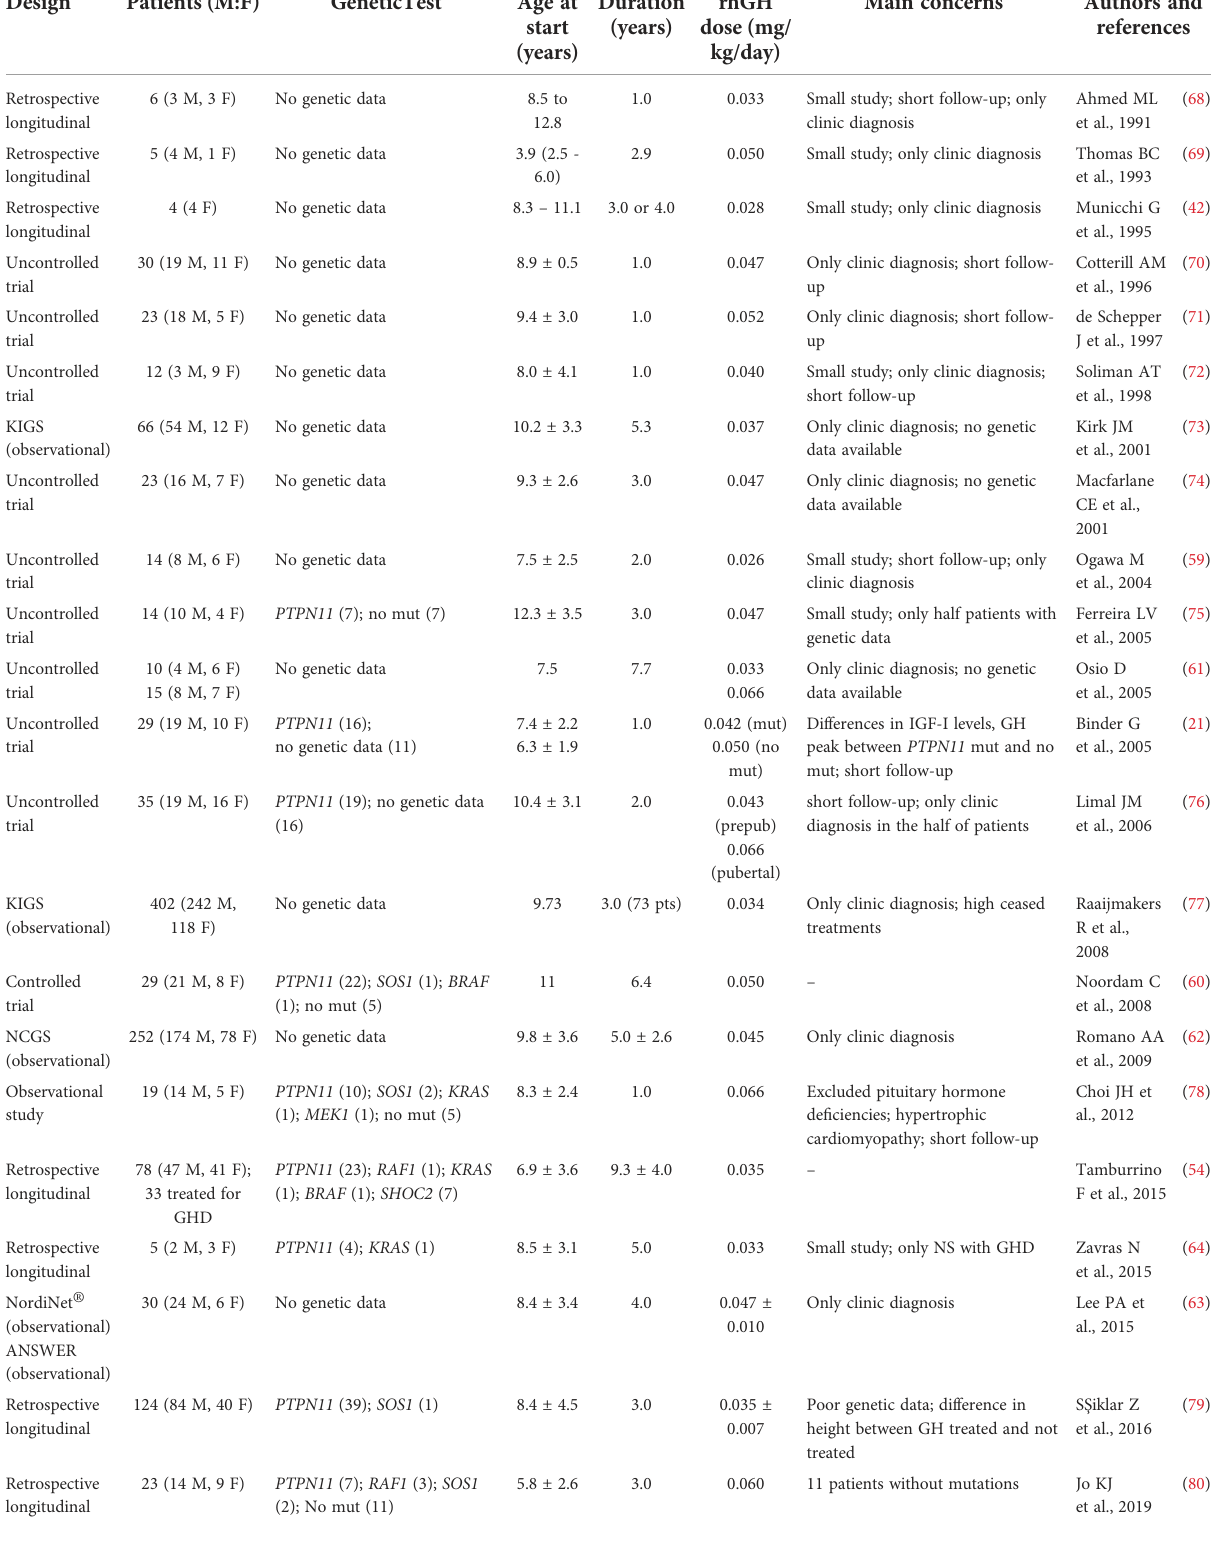
TABLE 1 Studies assessing the use of rhGH in Noonan syndrome. Design